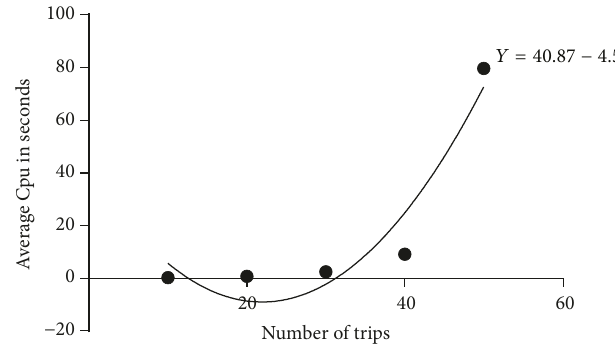
Figure 8: Results of the nonlinear regression.